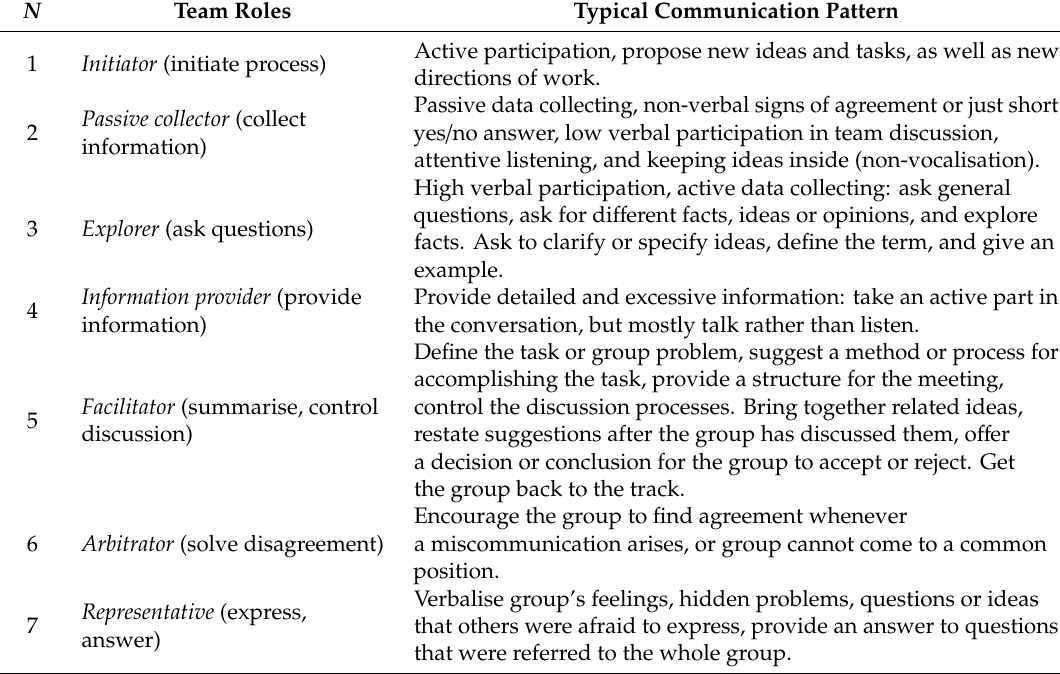
Table 1. Team roles per Nestsiarovich and Pons. Reproduced from [33] by